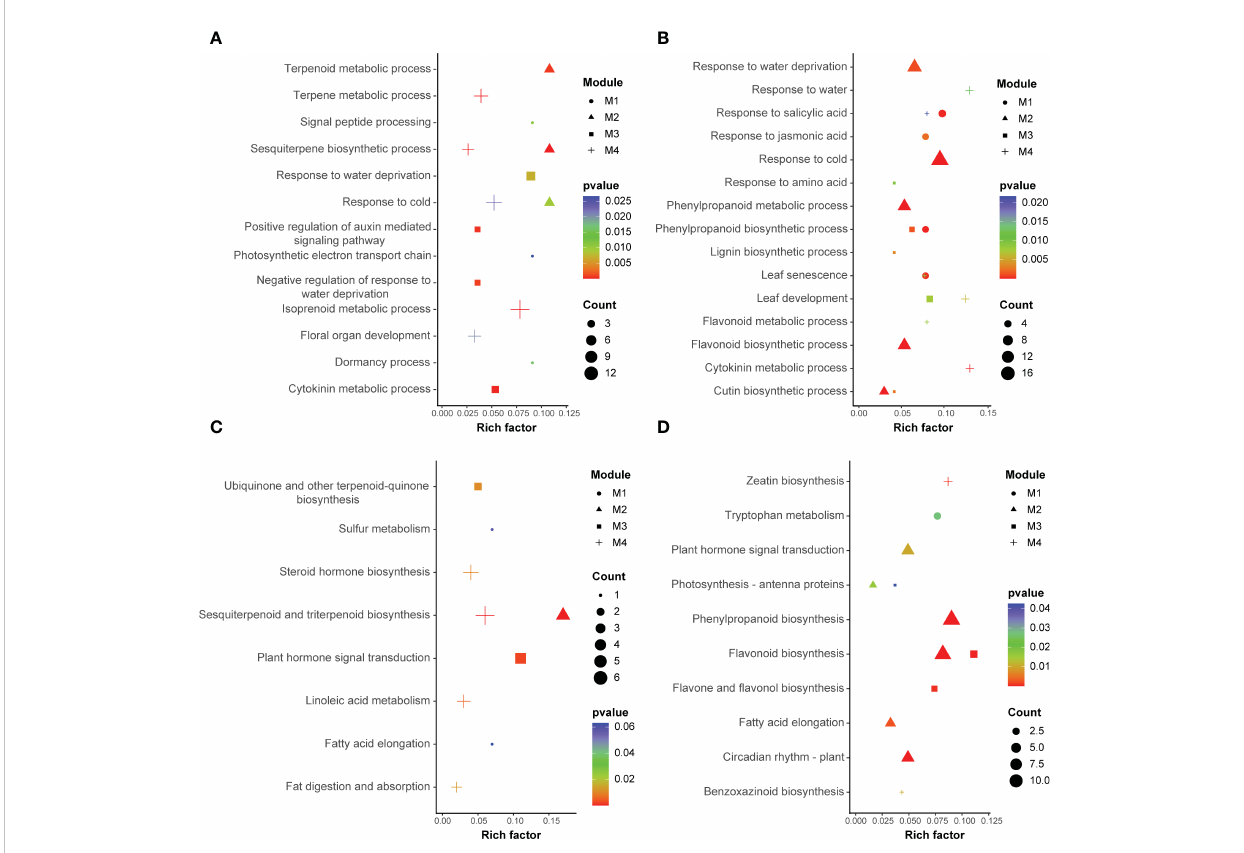
FIGURE 5 Results of GO enrichment (A, B) and KEGG enrichment (C, D) of signi fi cantly expressed unigenes in four different modules identi fi ed from late fl ower buds (A, C) and early leaf buds (B, D) , respectively. “ M1 ” , “ M2 ” , “ M3 ” and “ M4 ” refer to the modules that were signi fi cantly correlated with